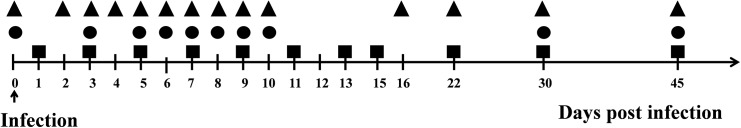
Schematic illustration of the experimental design.Each mouse in the infected group was inoculated intra-gastrically with 4 cysts of Pru strain at day 0. At the indicated days, blood samples (black square) were collected from tail vein and sera were separated for ELISA, while splenocytes were isolated from spleens for ICS (black circle) and IGRA (black triangle).